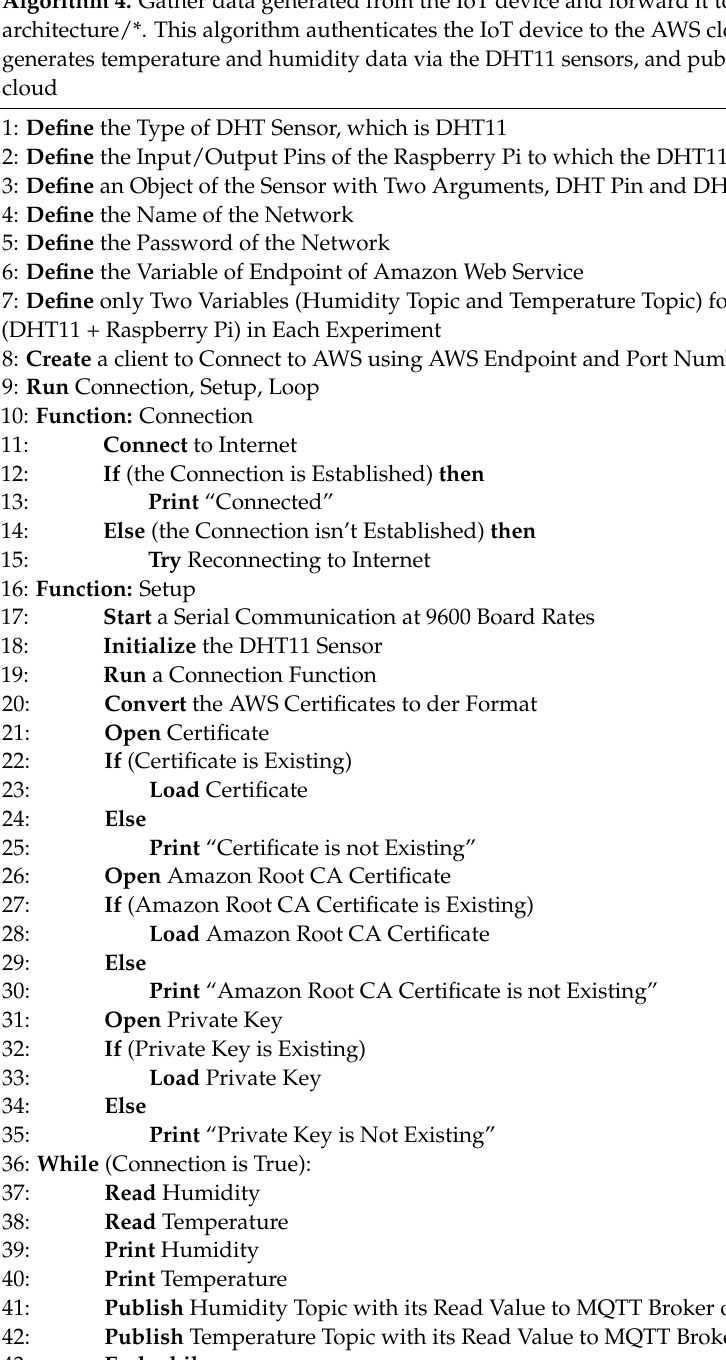
Algorithm 4. Gather data generated from the IoT device and forward it to the cloud—Second architecture/*. This algorithm authenticates the IoT device to the AWS cloud via certificates, generates temperature and humidity data via the DHT11 sensors, and publishes them to the AWS